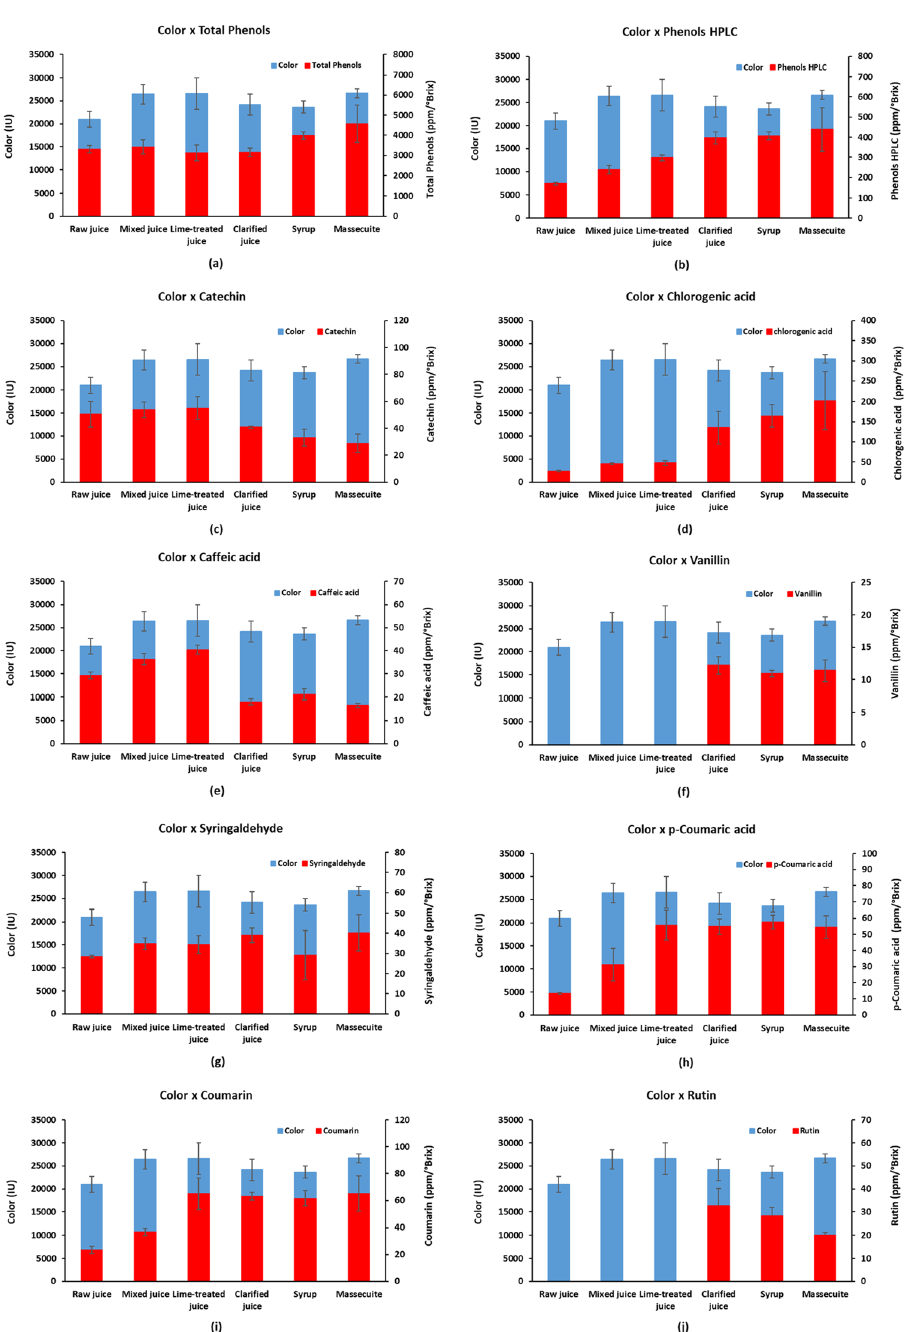
Figure 2. Relationship between color of sugarcane products and: ( a ) total phenols ( b ) total polyphenol content ( c ) catechin ( d ) Chlorogenic acid ( e ) caffeic acid ( f ) vanillin; ( g ) syringaldehyde; ( h ) p-coumaric acid; ( i ) coumarin ( j )